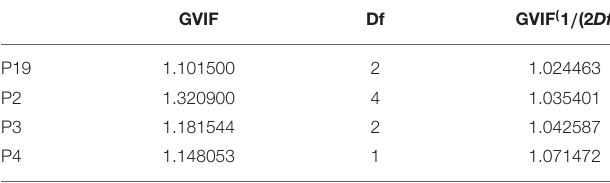
TABLE 5 | Multicollinearity as a function of variance inflation factors